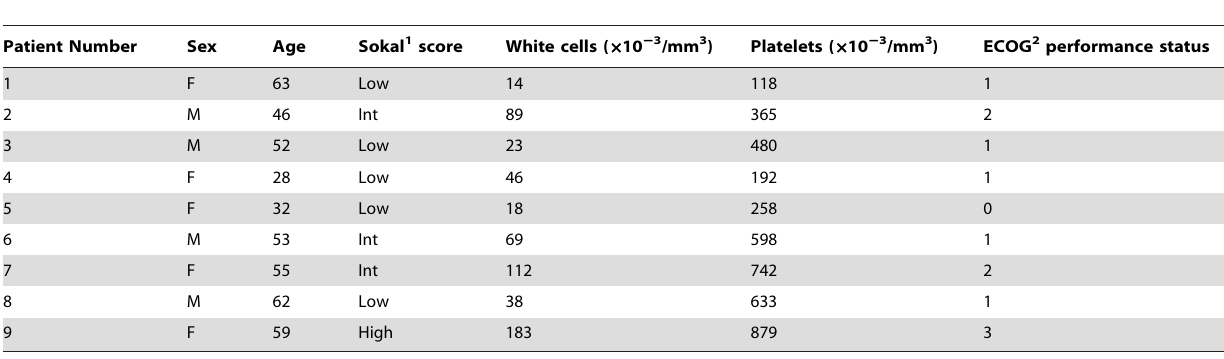
Table 1. Baseline patient